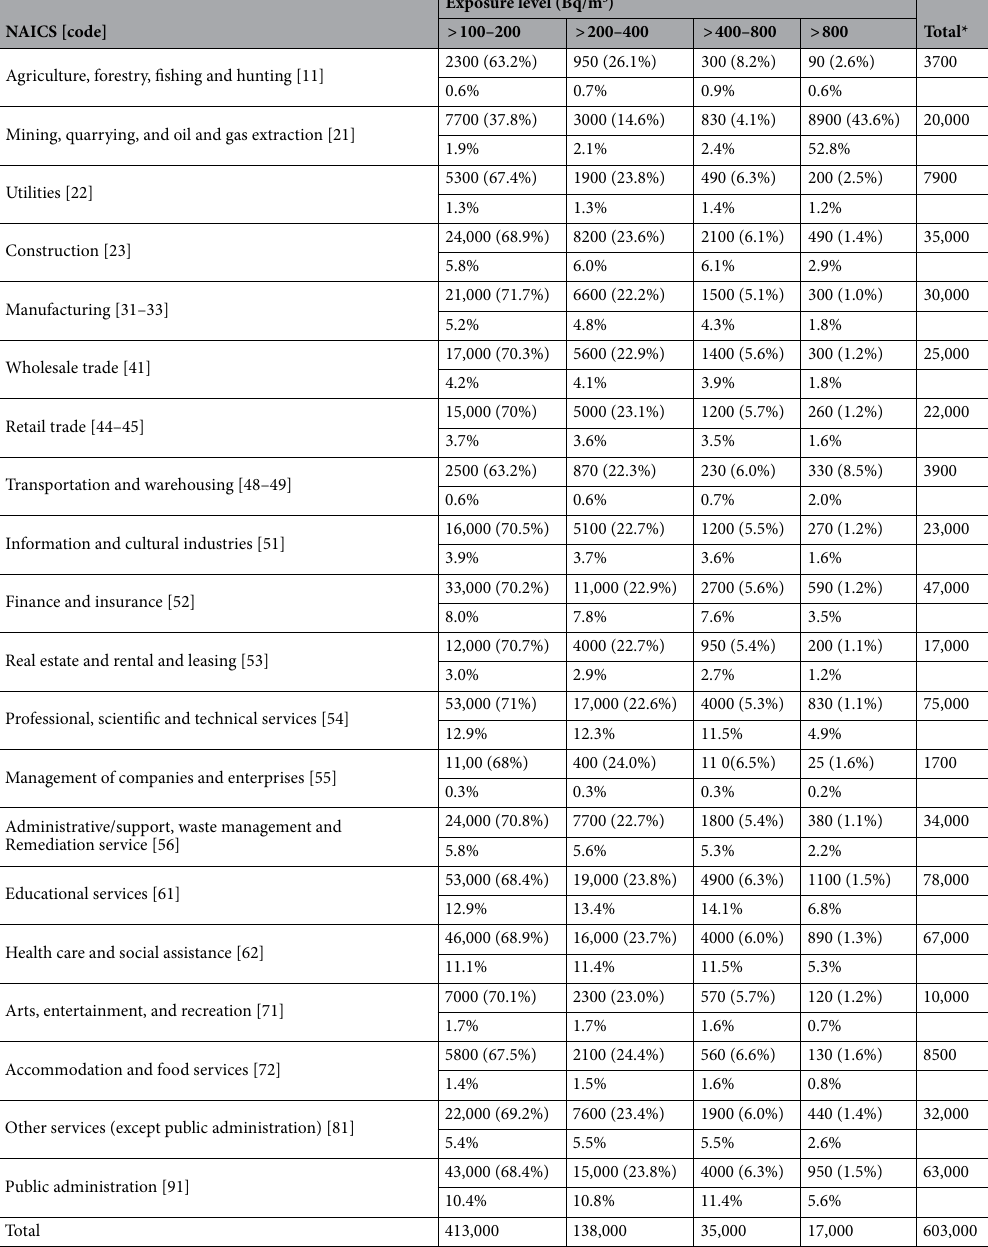
Table 2. Estimated number of workers exposed to radon by level of exposure and North American Industry Classification System (NAICS 2012)—2-digit sector. *Number of exposed may not add up to total because of rounding; row percentage in bracket; column percentage under each estimated